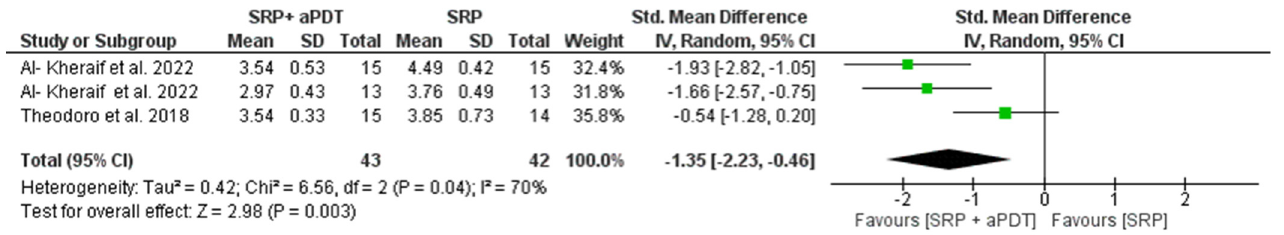
Figure 2. Forest plot of PD reduction at 3 months.